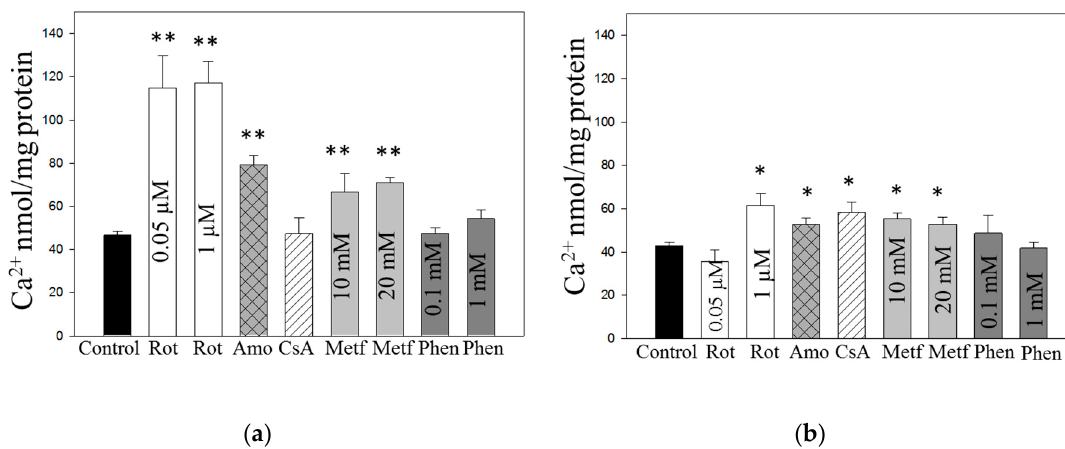
Figure 7. Ca 2 + retention capacity of brain cortex mitochondria isolated from 5–7 days ( a ) and 2–3 months ( b ) old rats. Mitochondrial calcium retention capacity (CRC) was measured fluorometrically using Calcium Green-5N as described in Methods. Where indicated, rotenone (Rot, 0.05 and 1 µ M), amobarbital (Amo, 2.5 mM), cyclopsorine A (CsA, 0.5 µ M), metformin (Metf, 10 and 20 mM) or phenformin (Phen, 0.1 and 1 mM) were added to isolated mitochondria 5 min before calcium pulses. The data are presented as means ± standard errors of 3–10 separate experiments. ∗ — p < 0.05, ∗∗ — p < 0.01 compared to the control of corresponding age group.